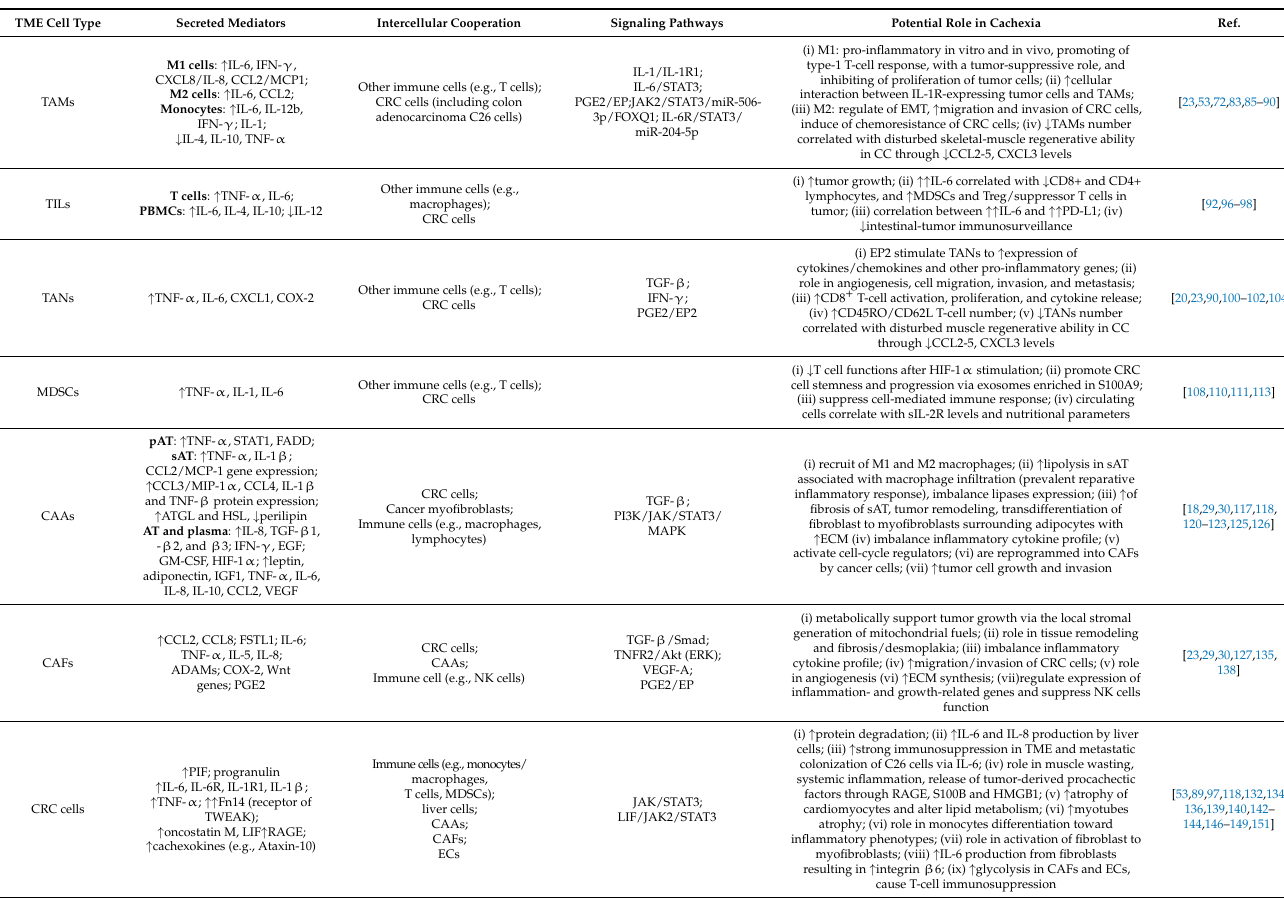
Table 2. The tumor microenvironment (TME) cellular components demonstrated in in vitro and in vivo models of colorectal cancer (CRC) cachexia and the known signaling pathways involved in this